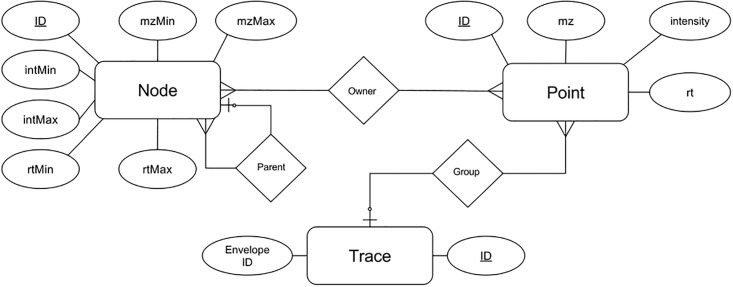
MzTree entity-relationship diagram.Entities modeled are MzTree Nodes, MS Data Points, and XICs (traces). The MzTree data store stores each entity relationally.